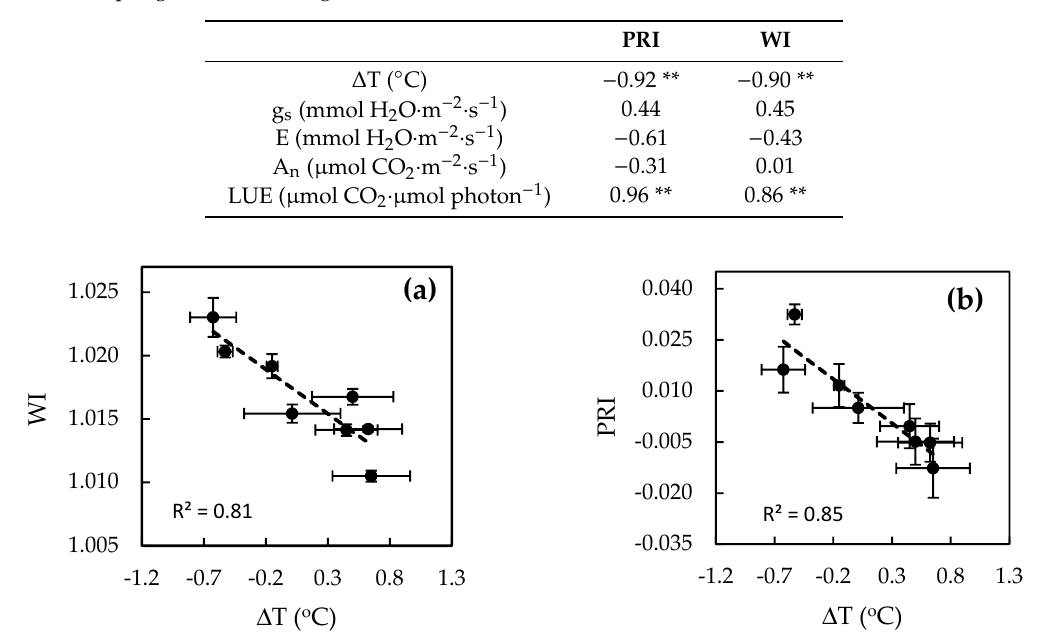
Table 1. Correlation coefficients between leaf-to-air temperature difference ( Δ T), stomatal conductance (g s ), transpiration (E), net photosynthesis (A n ), and light-use efficiency (LUE) and the reflectance indices, water index (WI) and photochemical reflectance index (PRI). Data are for average values at each sampling time ( n = 8). Significant correlations at the 0.01 (**) level are indicated.